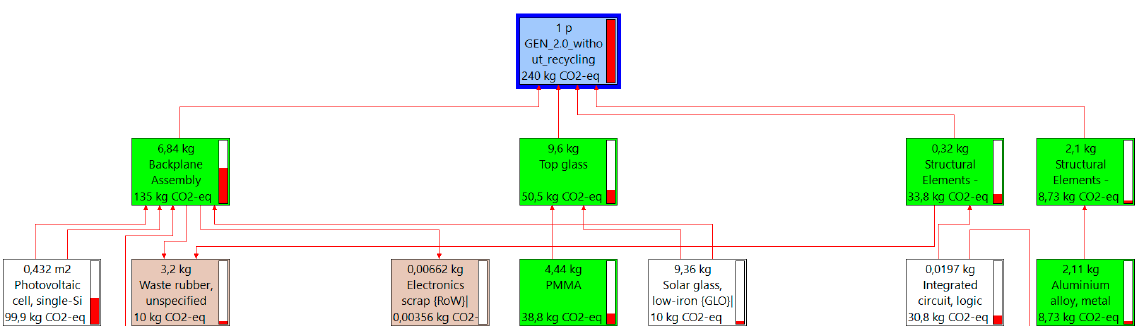
Figure 3. Reduced process showing the emission of CO 2 -eq. (in kg) of individual materials used in the production process of the module.